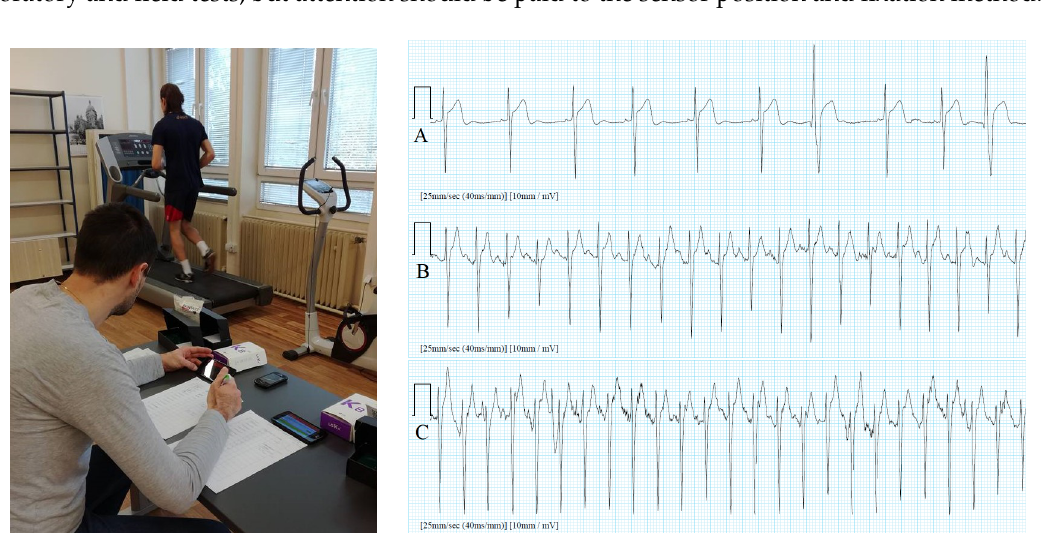
in Figure 12. Dots represent actual HR, i.e., 60/ ( t i − t i − 1 ) , where t i and t i − 1 are times of the current beat and the previous beat in seconds, respectively. Note that some dots, far-out from the HR